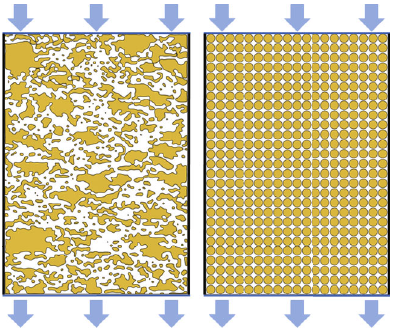
Figure 3: NMRI model and uniform